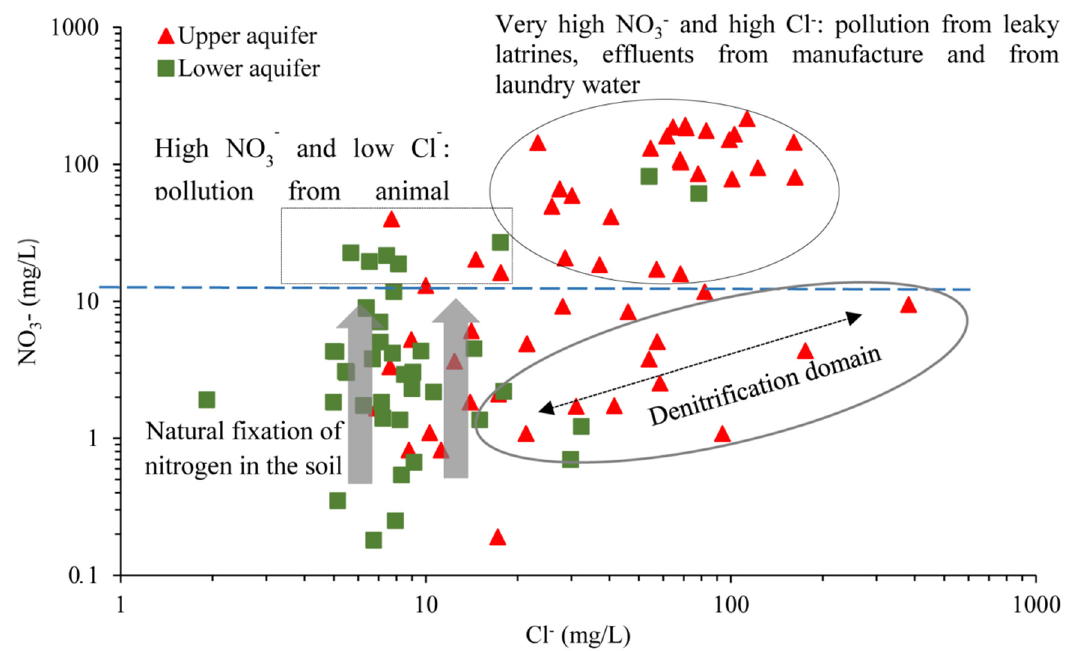
Figure 6. Plot of NO 3 − (mg/L) versus Cl − (mg/L) showing different sources of pollution. The dashed line corresponds to NO 3 − natural background level.